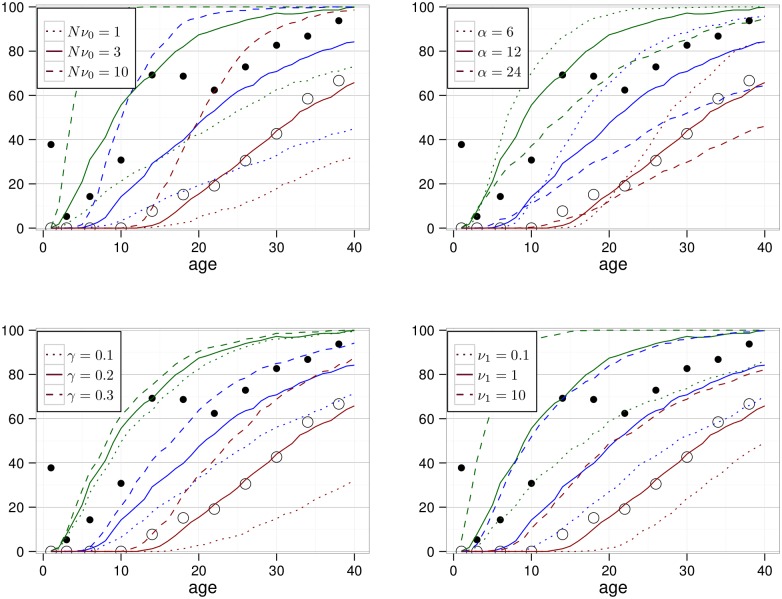
Modeled percentage of persons with at least X macrophages and foam cells (X = 102: green, X = 103: blue, X = 104: red).The solid lines correspond to the parameter set Nν0 = 3 year−1, α = 12 year−1, γ = 0.2 year−1, ν1 = 1 year−1 and ν2 = 10−7 year−1. In each panel, results of variation of a parameter are shown with dashed and dotted lines. Black dots are adopted from Fig 3 in ref. [46], a histological study of coronary arteries in persons who died from causes other than disease. Filled / open dots represent the observed percentage of persons with any lesion / a non-minimal lesion.